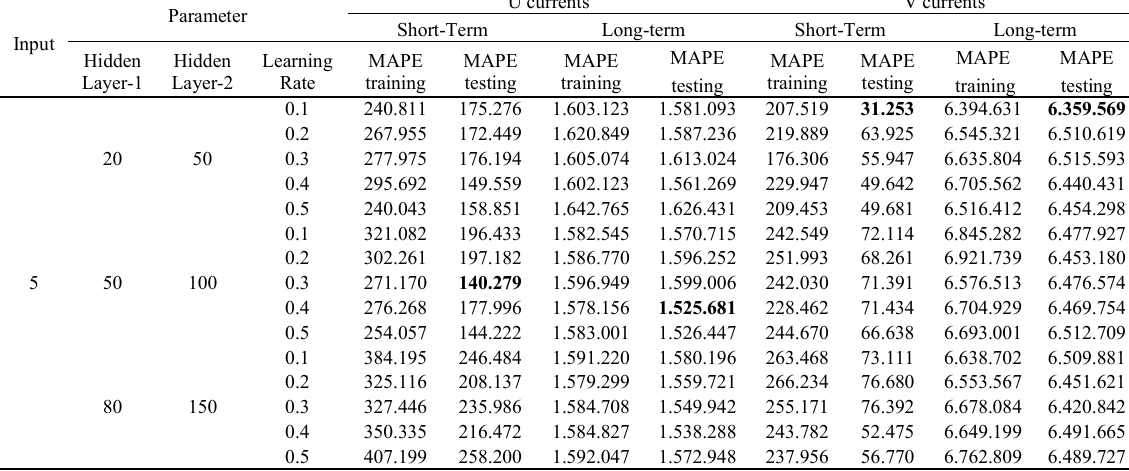
TABLE 4 T HE R ESULT O F T HE P REDICTION DATA OF U AND V CURRENTS